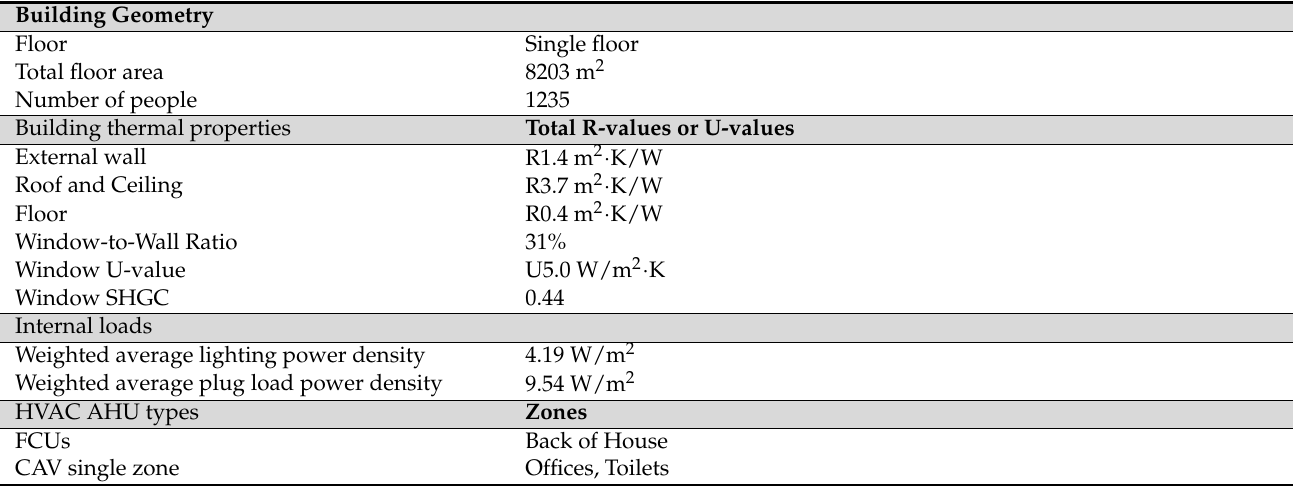
Figure 4. Small hospital building model. Table 6. Summary of the small hospital model specification.